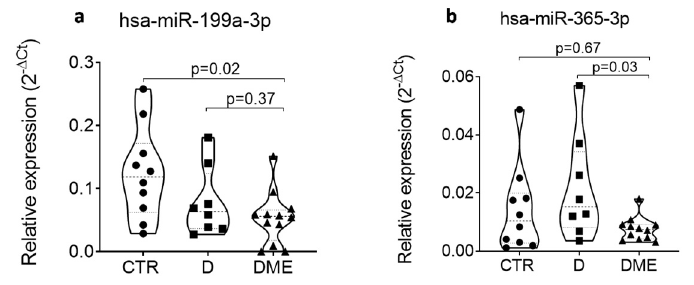
Figure 6. The expression of hsa-miR-199a-3p ( a ) is reduced in plasma of DME ( n = 12) vs. CTR ( n = 10) patients; the expression of hsa-miR-365-3p ( b ) is reduced in plasma of DME ( n = 12) vs. D ( n = 8) patients. miRNA expression is indicated as 2 − ∆ CT normalized for the expression of hsa-miR-191-5p and hsa-miR-320a-3p. Median values for each group are shown as dotted line alongside with quartiles (smaller dotted lines). p -values were considered significant with p < 0.05 using Mann–Whitney U